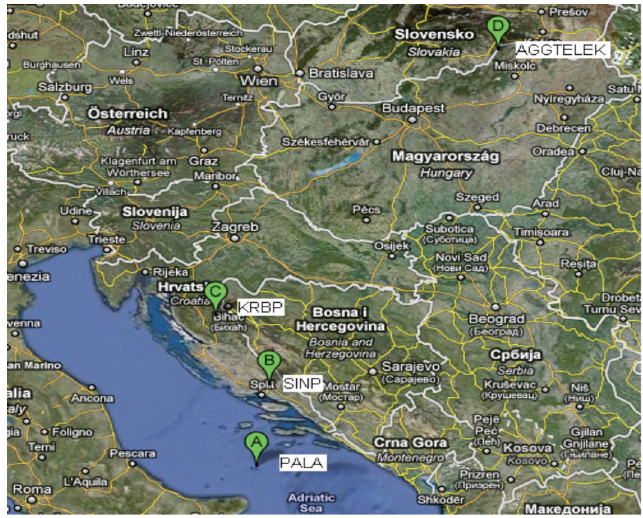
Figure 2. The repeat stations where the DIDD device was applied (from South to North PALAgruža, SINjsko Polje, KRBavsko Polje and